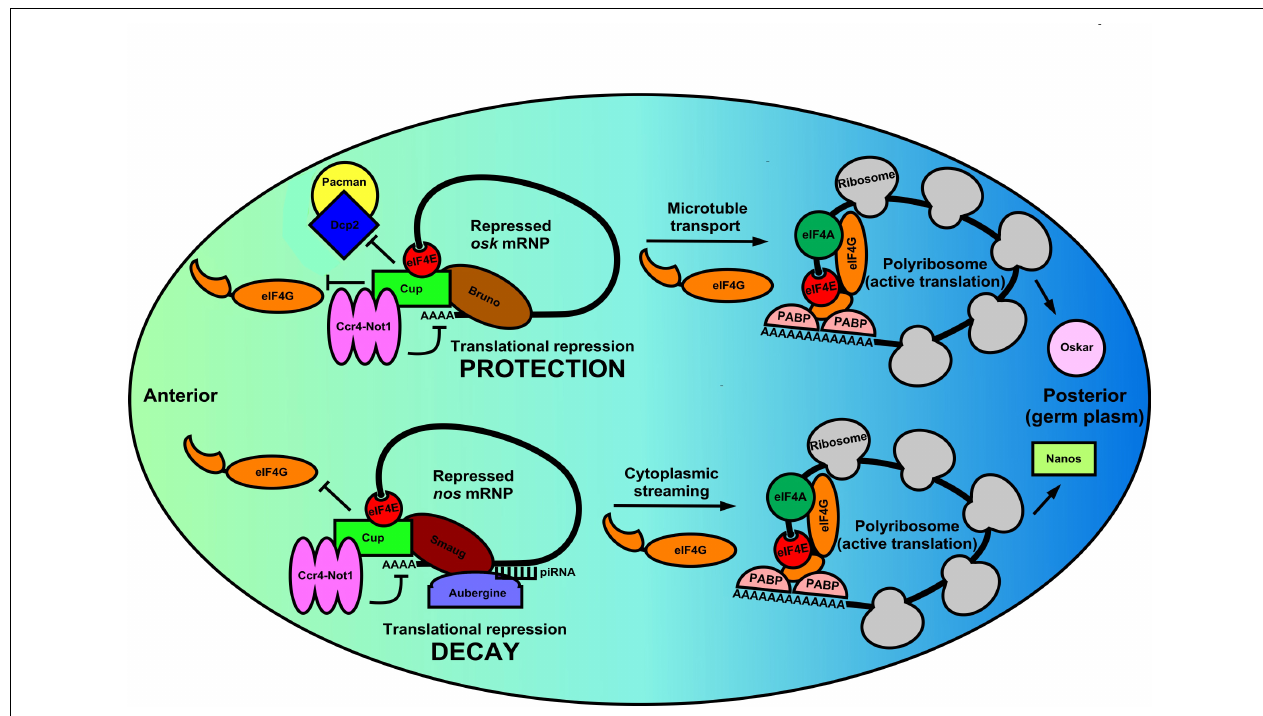
FIGURE 2 | Germ cell mRNPs use the same eIF4E:4EIP core but different RBPs for altered modes of local translation in the Drosophila oocyte. During the latter stages of Drosophila oogenesis many germline mRNPs like osk and nos are localized to and specifically translated in the germ plasm (posterior pole). These regulated mRNPs use the eIF4E:4EIP core, but each employs a unique mechanism to control mRNA stability, localization, and eventual translation. In the anterior region of the oocyte osk mRNPs are circularized by a core complex containing the oocyte eIF4E, Cup (4EIP), and Bruno (3 (cid:48) -UTR-binding protein). Cup prevents eIF4E:eIF4G binding while simultaneously recruiting the Ccr4-Not1 deadenylase complex. Because eIF4E:Cup also prevents de-capping and 5 (cid:48) -3 (cid:48) decay by the Dcp2/Pacman complex, osk mRNA is protected and translationally silent while being shuttled to the posterior pole via microtubules. Similarly, nos mRNPs in the anterior region of the oocyte are circularized by a eIF4E:Cup:Smaug complex, which again prevents translation initiation and recruits Ccr4-Not1. Unlike osk , however, nos mRNA localizes by cytoplasmic streaming that is inefficient. Therefore, Smaug recruits Aubergine and associated piRNA machinery to degrade nos mRNA outside the germ plasm. Little is known about the events that promote translational activation of these two distinct mRNPs. However, it is likely that a remodeling occurs in which Cup is displaced by eIF4G leading to polyribosome recruitment. Additionally, Oskar protein translationally activates the nos mRNP, indicating a complex interplay of translational regulation regimens that ensure that germ cell determinants are synthesized in correct time and